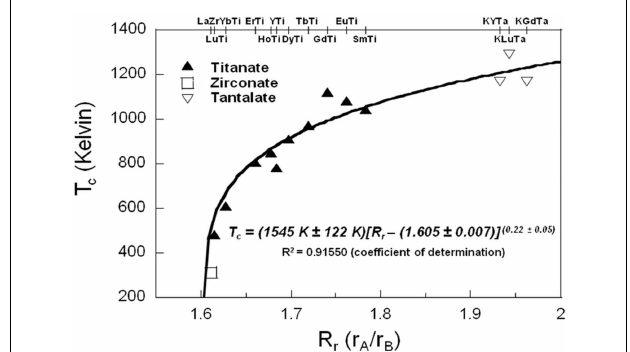
FIGURE 6 | Correlation ofA–B site ionic radius ratio (r A /r B ) with critical amorphization temperature ( T c ) for titanate and zirconateA 2 B 2 O 7 pyrochlores and tantalate K x Ln y Ta 2 O 7-v pyrochlores .The different cation compositions of these pyrochlores are indicated in the upper x -axis, where the titanate and zirconate pyrochlores are indicated by the A and B site cations in the form of “A–B,” and the tantalate pyrochlores are indicated by “KGdTa” (representing K 0.8 GdTa 2 O 6.9 ), “KYTa” (representing K 0.8 YTa 2 O 6.9 ), and “KLuTa” (representing KLuTa 2 O 7 ).The empirical power-law fitting equation of T c = (1545 ± 122K) [ R r –(1.605 ± 0.007)] (0.22 ± 0.05) and the R 2 of fitting (coefficient of determination) is given at the lower right of the